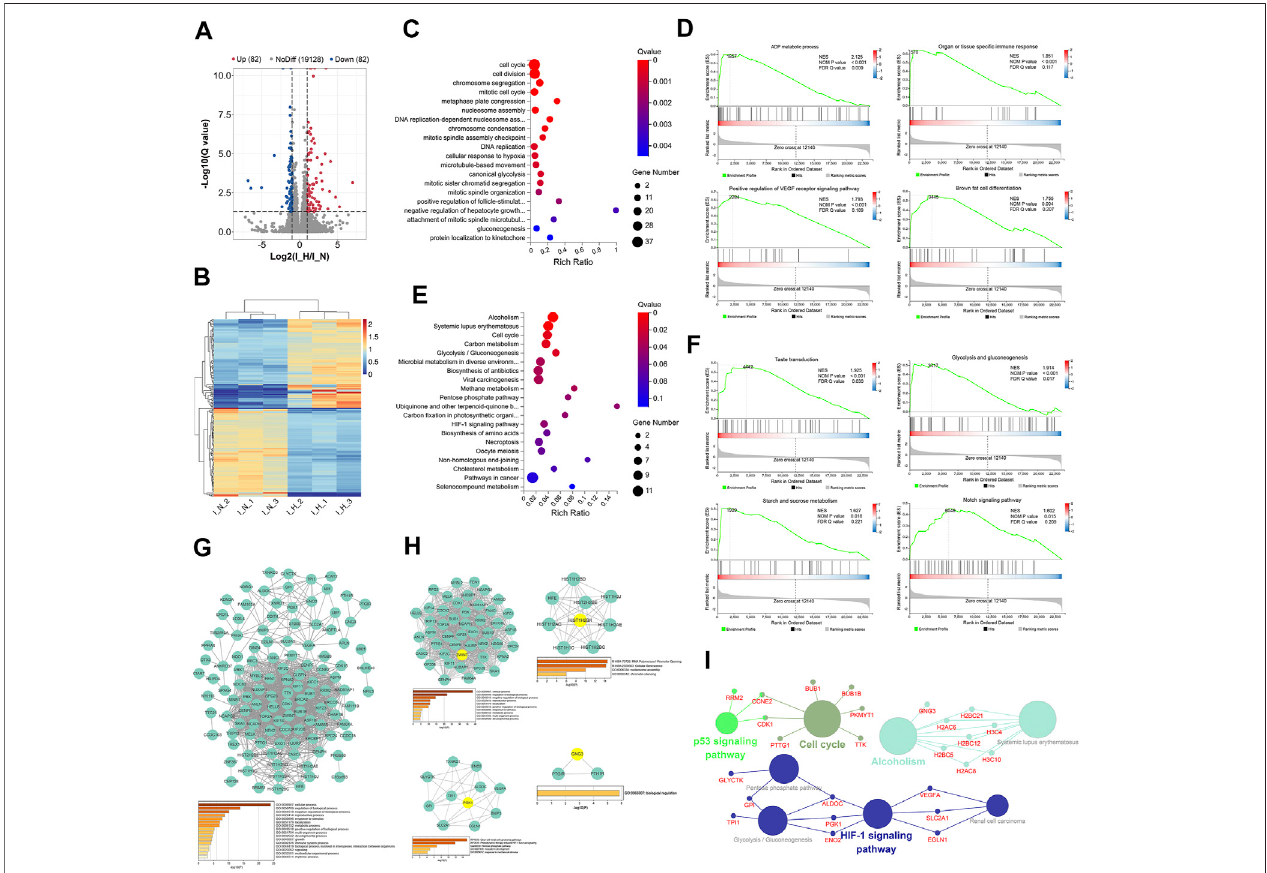
FIGURE3| Identi fi cationandfunctionalanalysisofdifferentiallyexpressedgenes(DEGs)innormoxia-treatedin fl ammatoryhPDLSCs(I_N)comparedwithhypoxia- treated in fl ammatoryhPDLSCs(I_H). (A) Volcano map ofDEGs analyzed by DESeq2 (|log2 FC| ≥ 1; Q value ≤ 0.05); the red dots represent upregulated DEGs, the green dots represent downregulatedDEGs,and thegray dotsrepresent genesshowingnonsigni fi cantdifferences inexpression. (B) Expression heatmapofeach samplewith the expression standardized by log (expression+1); each row represents a gene, each column represents a sample, and the colors in the panels represent the relativeexpressionlevels,withblueindicatinglowexpressionandredindicatinghighexpression. (C) GeneOntology(GO)enrichmentanalysesoftheDEGs. (D) Geneset enrichment analysis (GSEA) of biological processes, including ADP metabolic processes, organ or tissue speci fi c immune responses, positive regulation of the vascular endothelial growth factor receptor (VEGFR) signaling pathway, and brown fat cell differentiation. (E) Kyoto Encyclopedia of Genes and Genomes (KEGG) enrichment analysesoftheDEGs. (F) GSEA ofKEGG pathways identi fi ed, including taste transduction,glycolysis/gluconeogenesis,starchand sucrose metabolism, and theNotch signaling pathway. (G) PPI network of the DEGs and the three most highly correlated hub genes. (H) Signi fi cant modules of the PPI network and the hub gene showing thehighestcorrelationwitheachmodule;thehubgenesareshowninyellow. (I)